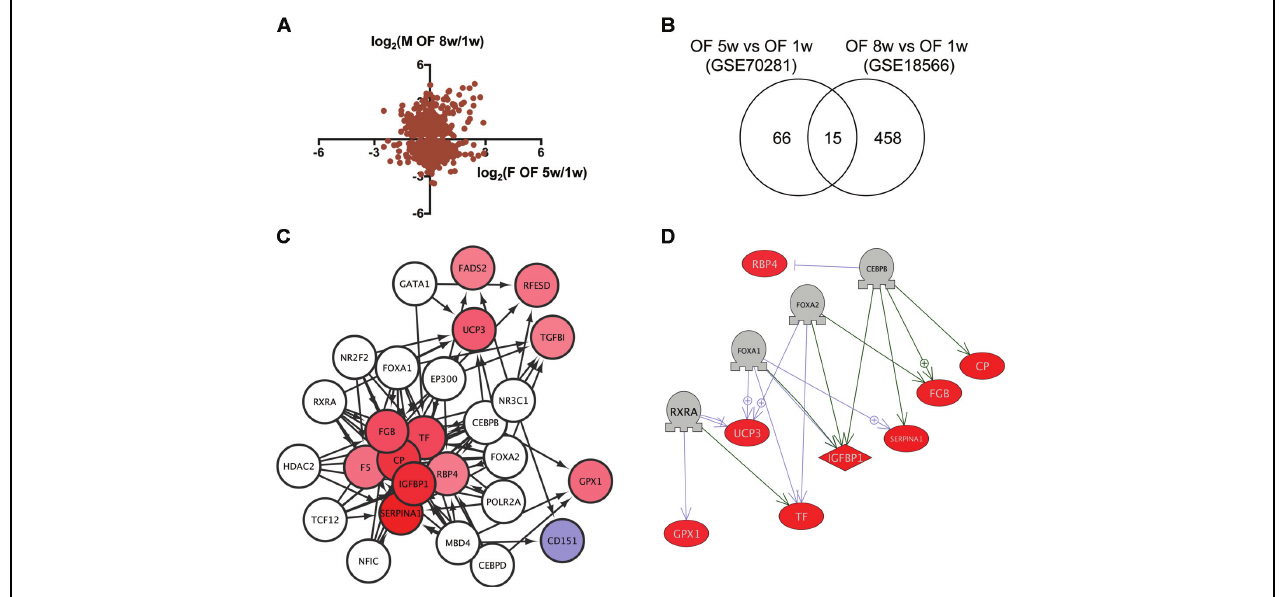
FIGURE 3 | Identification of the regulatory network for genes dysregulated in DIO zebrafish. (A) Correlation of the change in gene expression in DIO female and male zebrafish. (B) Venn diagram of the numbers of DEG in DIO female and male zebrafish. (C) A regulatory network identified by iRegulon for the 15 common genes between female and male DIO zebrafish. Genes shown in blue and red indicate decreased and increased expression, respectively, by obesity. (D) A regulatory network identified by Pathway Studio for four regulators and their eight target genes. Genes shown in blue and red indicate decreased and increased expression, respectively, by